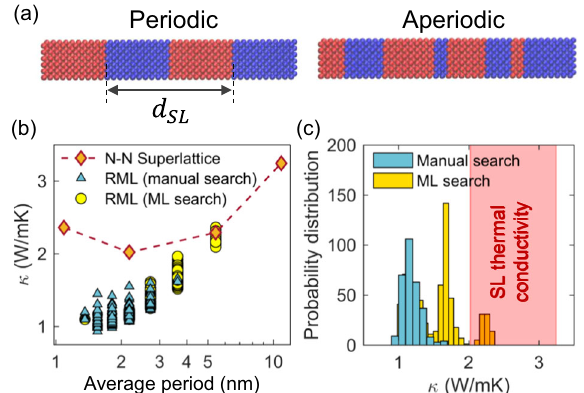
Fig. 1 Results of a manual search for aperiodic superlattices with enhanced thermal conductivity. a Schematic of the Si/Ge periodic SL (left) and aperiodic SL or RML (right). b Variation of κ l with average period at 300 K for RML structures generated during the manual random search (triangles) and the machine learning accelerated search (circles). The thermal conductivities of the reference N − N superlattices are indicated by the diamonds. c Probability distributions of thermal conductivities (W/mK) of the RML structures generated by a manual search (blue bars) and the ML search (yellow bars). The region spanned by the thermal conductiv- ities of the N − N SLs is shaded in